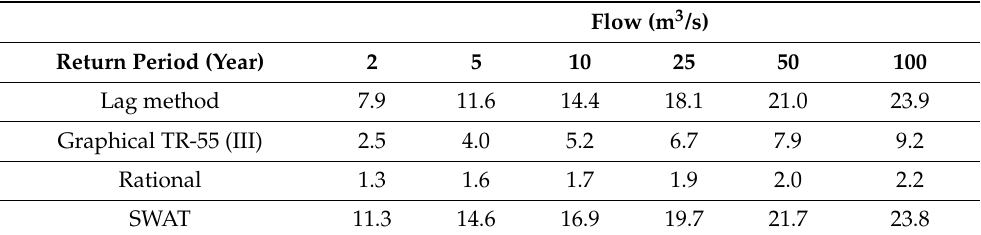
Table 3. Comparison of flow calculation methods for the Congo Valley River baseline LULC